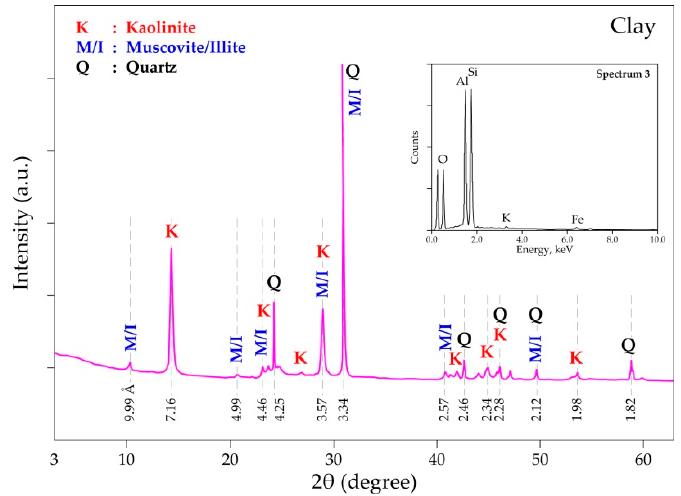
Figure 6. XRD diffractogram and embedded SEM-EDS spectrum (top right corner) of the clay sample.